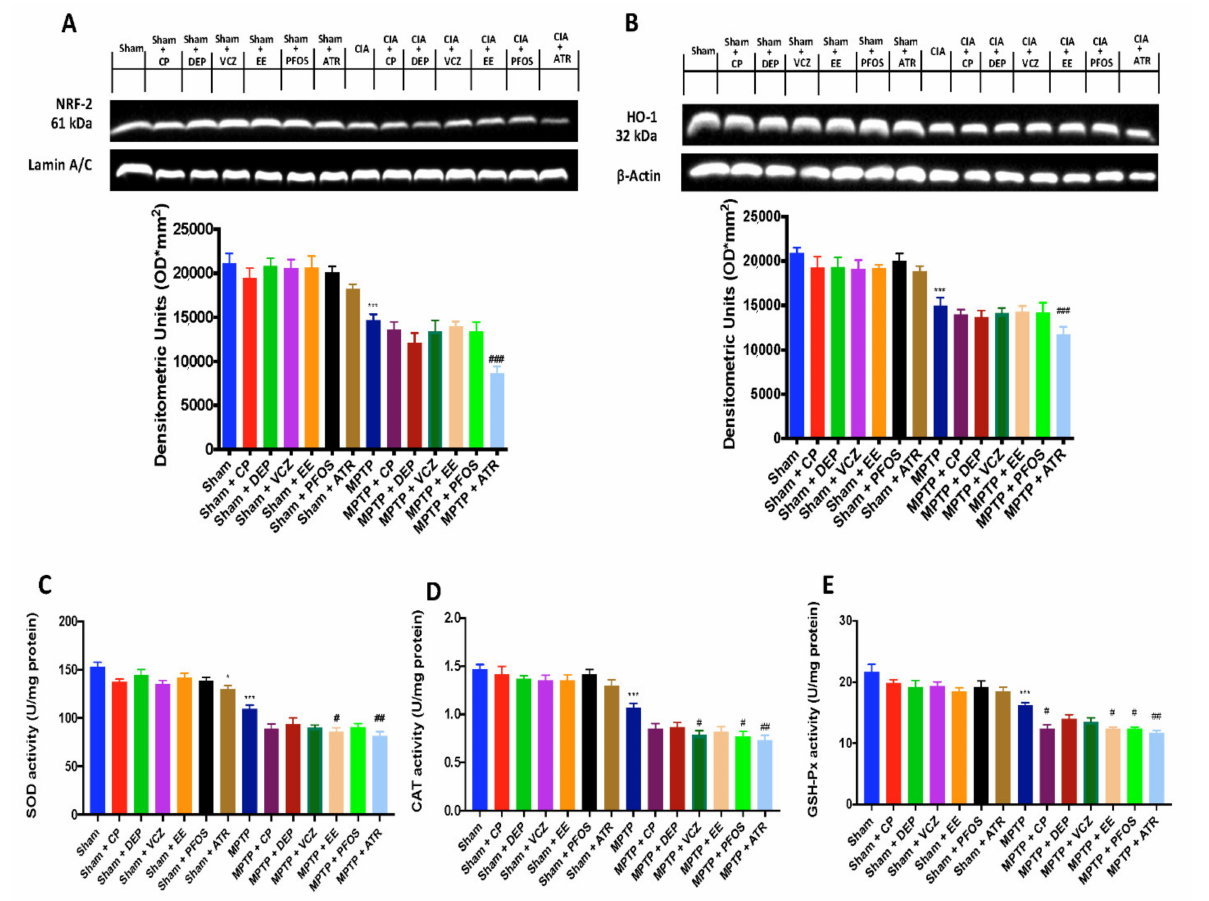
Figure 5. Western blots and densitometric analysis of NRF-2 ( A ) and HO-1 ( B ). Levels of SOD ( C ), CAT ( D ) and GSH-Px ( E ). A demonstrative blot of lysates with a densitometric analysis for all animals is shown. Data are expressed as the mean ± SEM of N = 6 mice/group. * p <0.05 vs. sham; *** p < 0.001 vs. sham; # p < 0.05 vs. MPTP; ## p < 0.01 vs. MPTP; ### p < 0.001 vs.